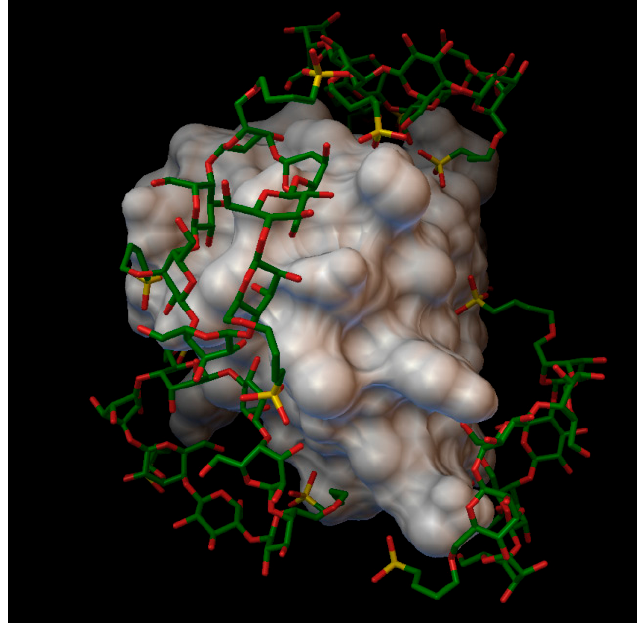
Figure 14. Insulin-sulfobutylether- β -cyclodextrin (DS 3) complex. The insulin molecular surface is marked with white and the cyclodextrin molecules are marked with green and red licorice.